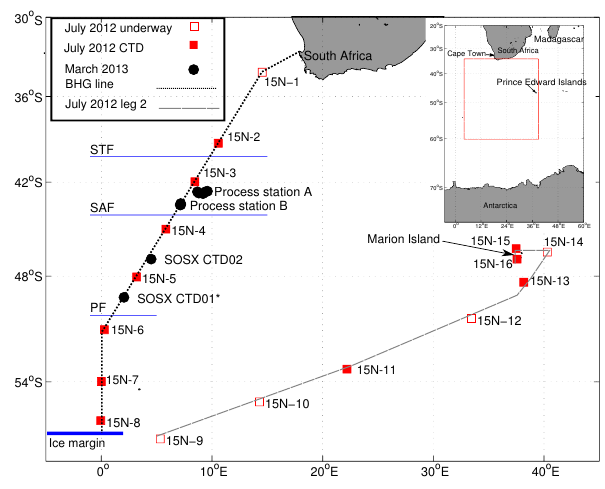
Figure 1. Cruise track for the two cruises. Leg 1 of winter cruise ex- tended from Cape Town to the ice margin 58 ◦ S and leg 2 from the ice margin to Marion Island. The winter frontal and ice margin posi- tions are indicated by the blue lines. STF represents the subtropical front, SAF the subantarctic front and PF the polar front. The black dotted line (BGH line) shows the GoodHope (also referred to as Bonus-GoodHope) line while the grey dashed line shows the cruise track on leg 2 of the winter